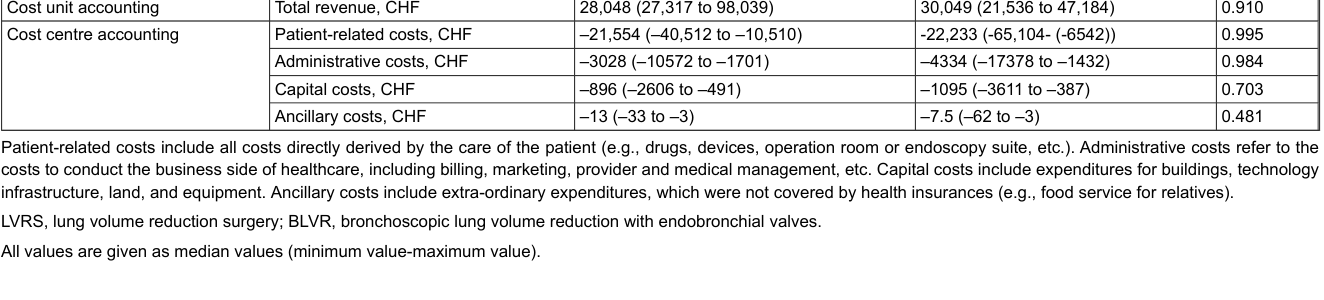
Table 6: Costs per effectiveness level after lung volume